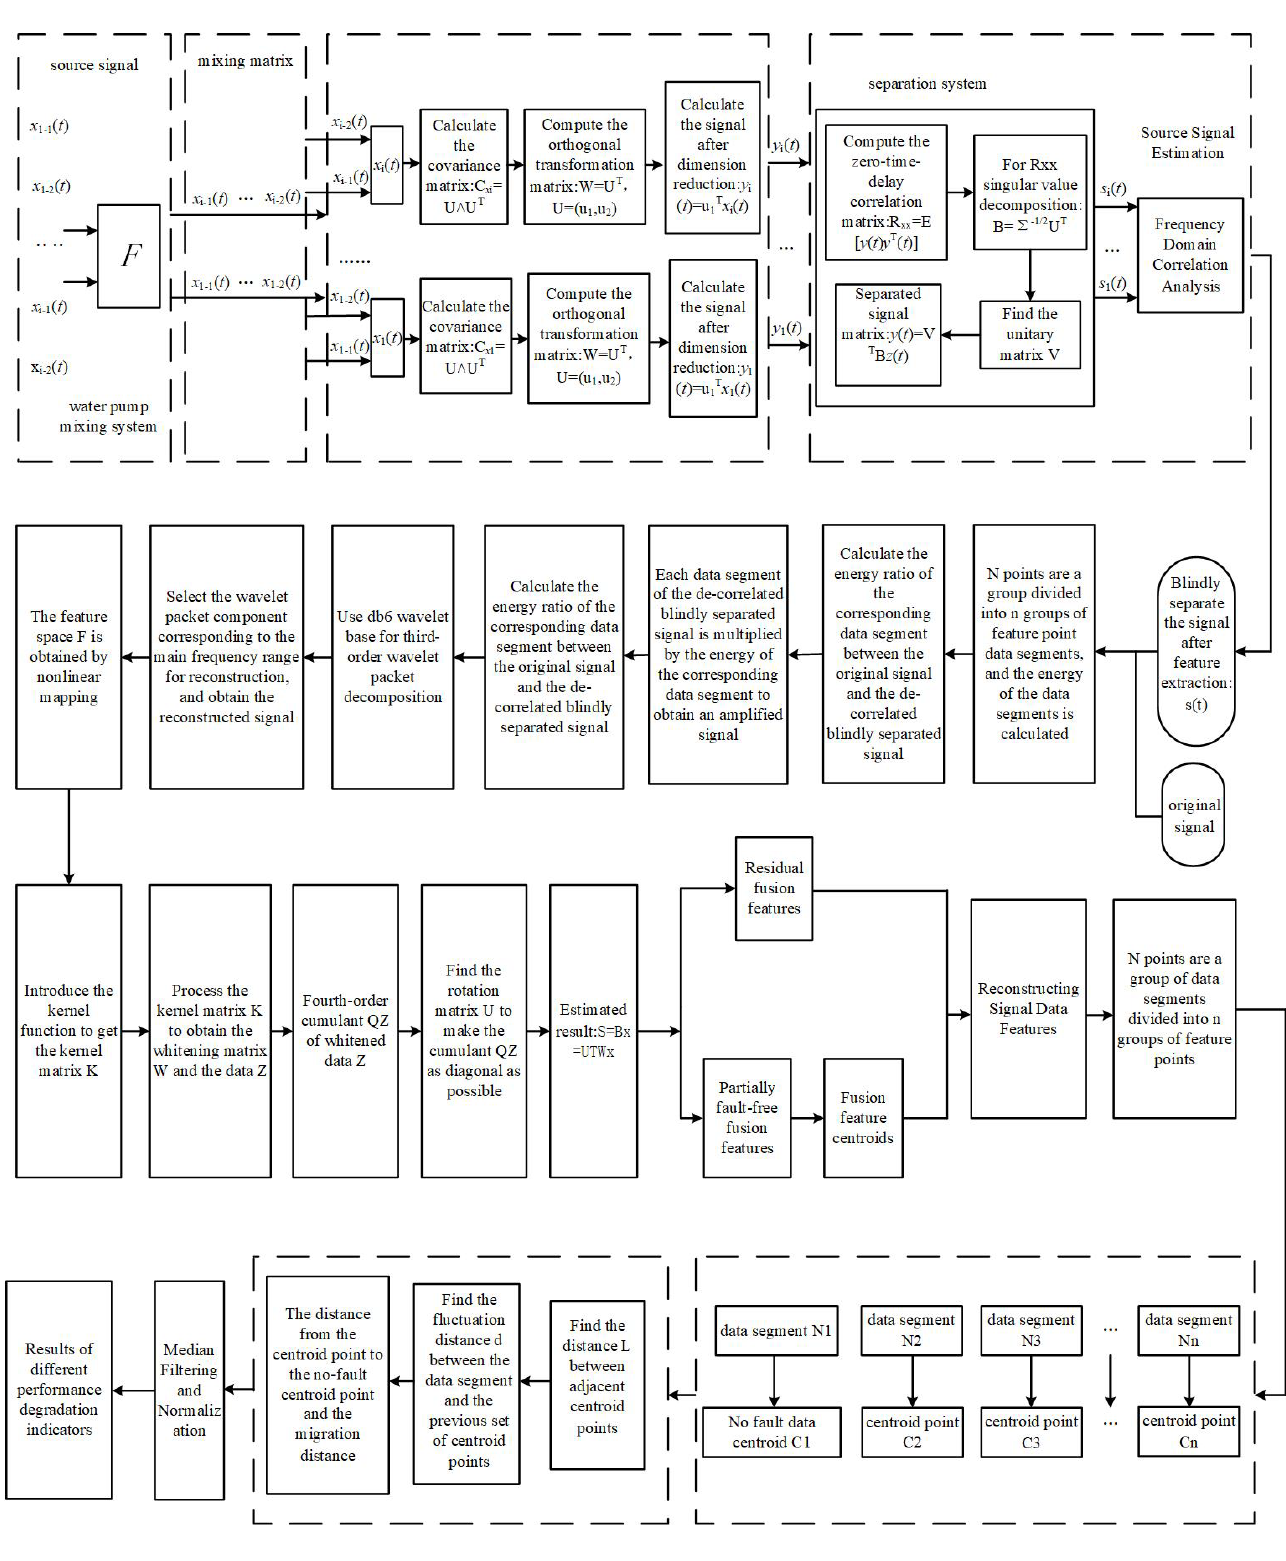
Figure 2. Overall algorithm flow chart.